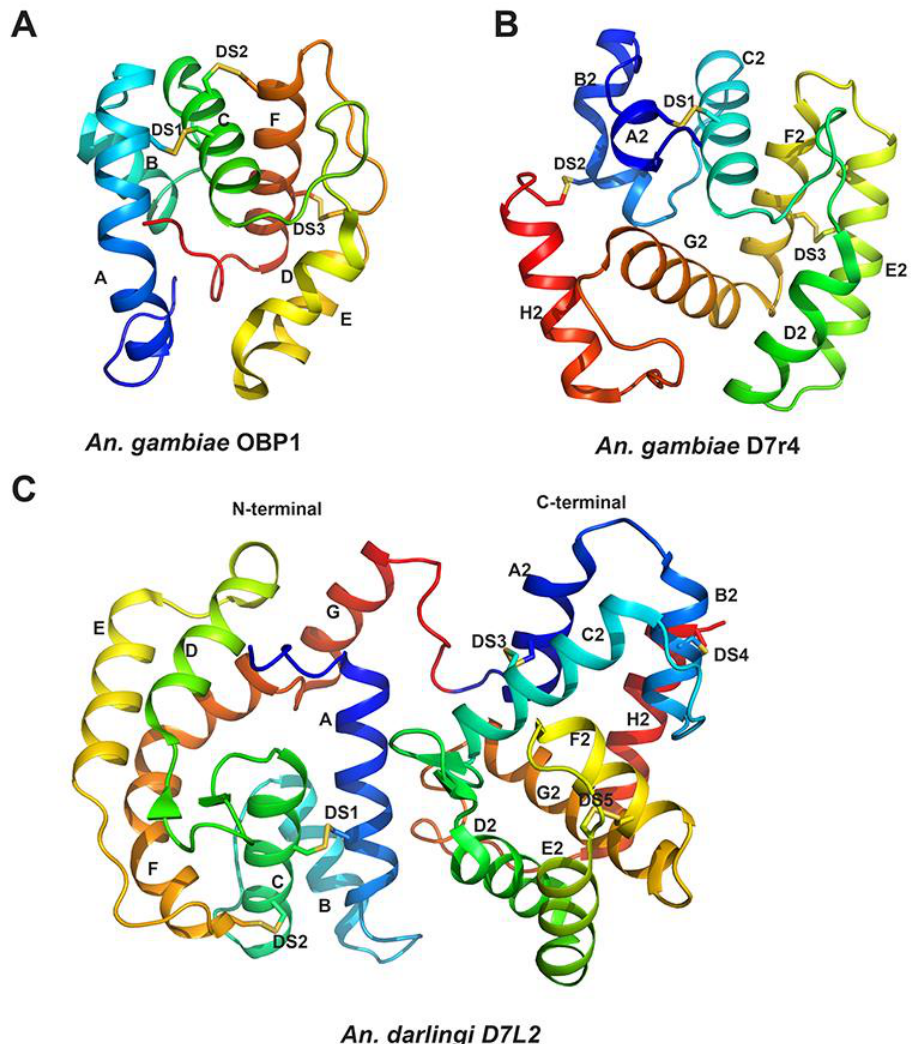
Figure 1. General structure of classical OBPs and D7 proteins — ( A ) Ribbon diagram of Anopheles gambiae OBP1 (PDB: 2ERB) [25] representing a classical OBP structure composed by 6 α -helices (labeled A–F) stabilized by 3 disulfide bonds (DS1–DS3) forming a central cavity. Original structure was obtained complexed with PEG. ( B ) Anopheles gambiae D7r4 crystallized in its apo form (PDB: 2QEV) [28] representing a D7r protein general structure composed by 8 α -helices (A2–H2) stabilized by 3 disulfide bonds (DS1–DS3). ( C ) Anopheles darlingi D7L2 (PDB:7U1N) on its apo form, representing long form D7s, composed by 2 OBP-like domains. N-terminal domain is composed by 7 α -helices